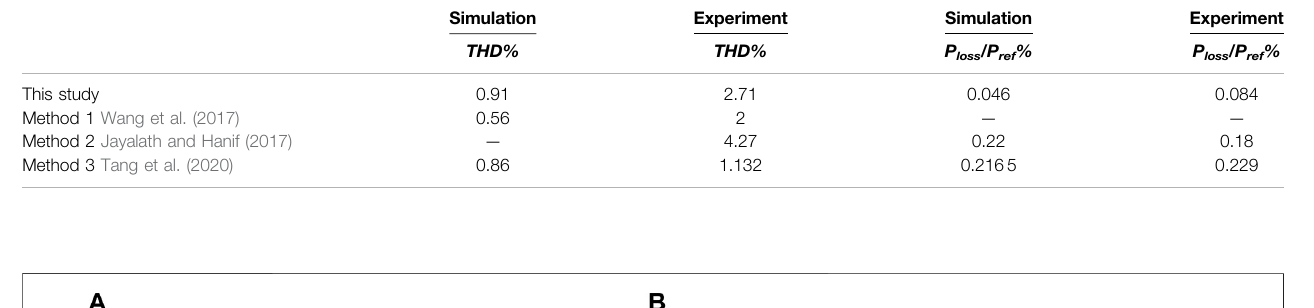
TABLE 5 | Simulation and experimental values of THD and loss ratio with different methods.